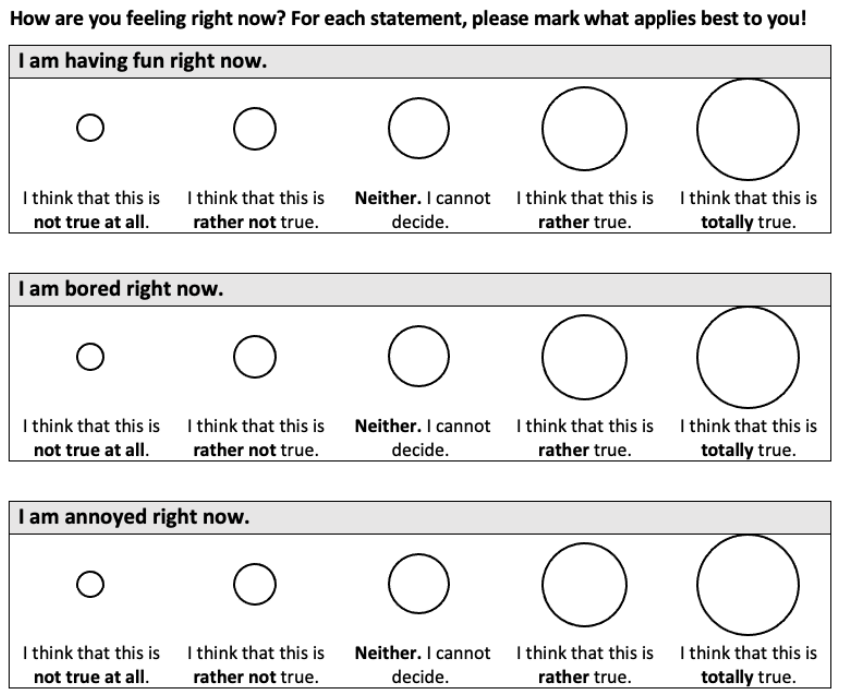
Figure A1. Pre-questionnaire for activity-related achievement emotions assessment.